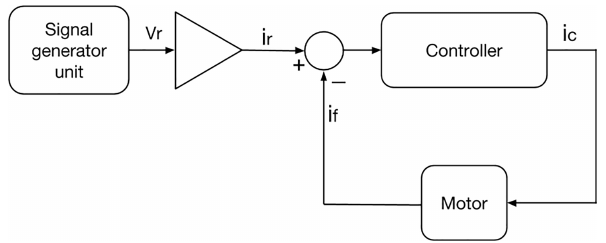
Figure 8. Block diagram of motor and motor drive configuration.